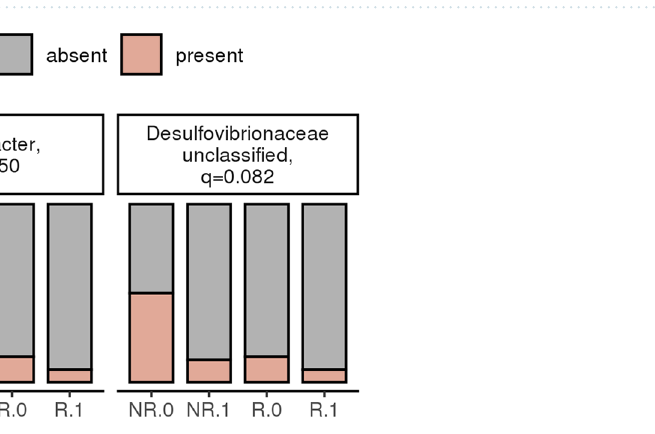
In particular, the bacteria most significantly affected by diet (q < 0.1) were more frequently observed in non- responders (dark purple circles in panel A ). Bifidobacterium was the only significant genus that increased in abundance post-diet, an effect that was observed in both responders and non-responders.